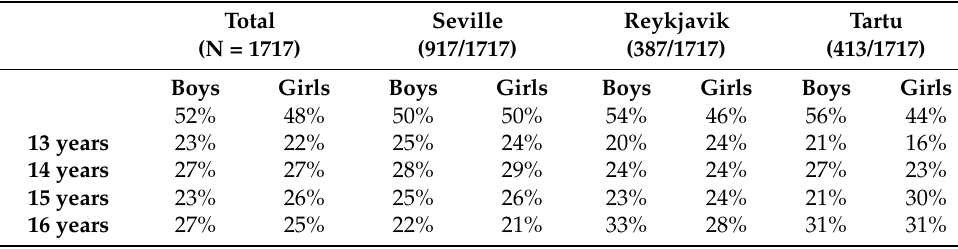
Table 1. Participants from the three cities by